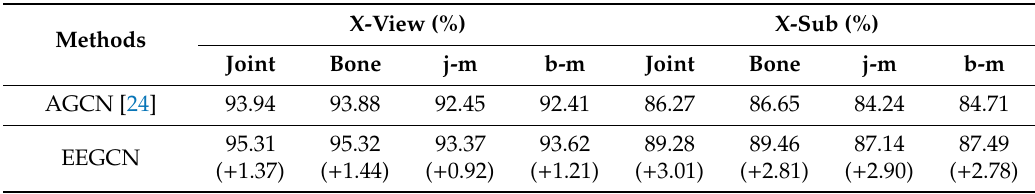
Table 5. The accuracy comparisons between AGCN [24] and EEGCN with four modalities on X-View and X-Sub benchmarks.